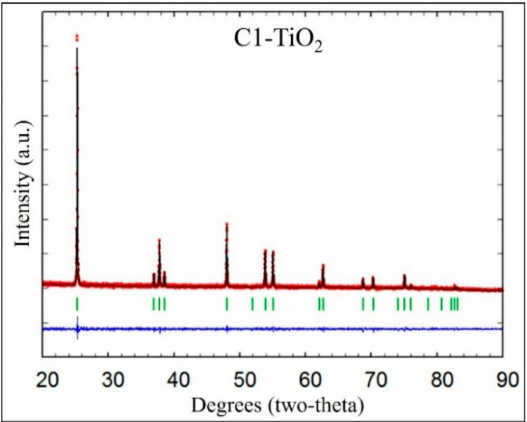
Figure 2. XRD pattern for the commercial C1-TiO 2 sample. The green vertical bars correspond to the TiO 2 anatase JCPDS 00-021-1272 phase.